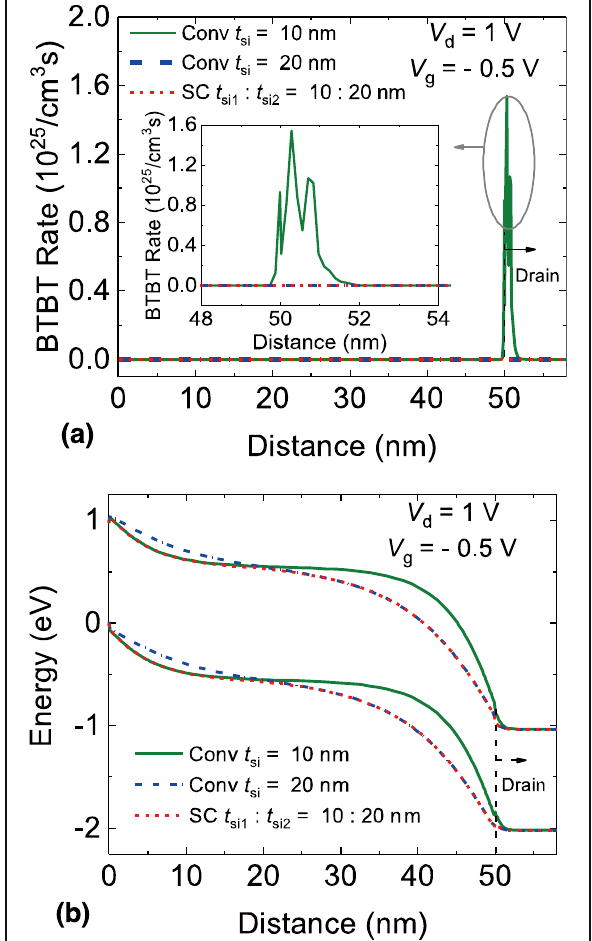
Fig. 4 a BTBT rates and b energy band diagram of the SC TFET and the conventional DG TFETs in the ambipolar-state, distance is the lateral position of the cutline AA ’ in Fig.